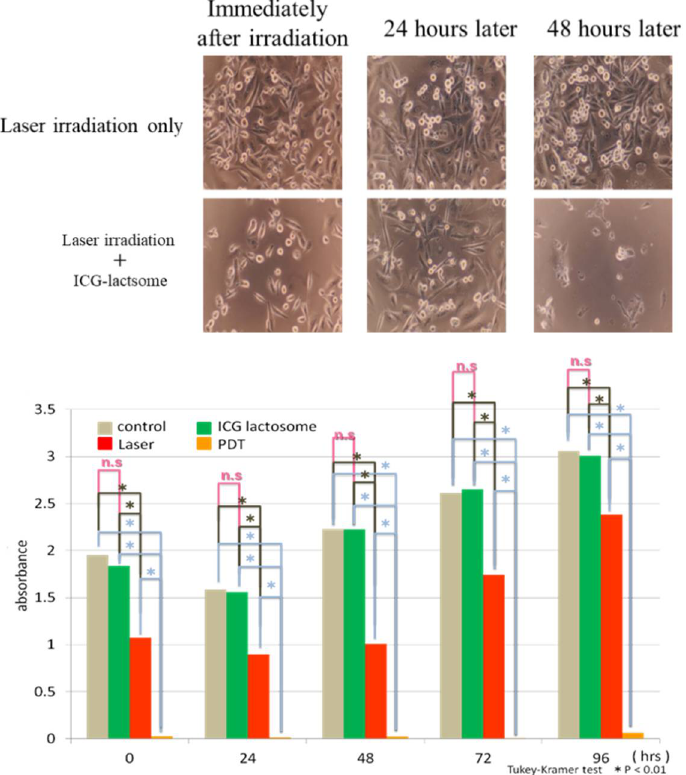
Figure 4. Tumor cell proliferation of the human breast cancer cell line MDA-MB-231 is suppressed by ICG-lactosomes. ICG-lactosomes combined with laser irradiation abolished cells (lower panels). Mean absorbance values indicate cell viability in the WST-1 assay. The laser-irradiated group ( red ) showed significantly lower cell viability than the control and ICG-lactosome alone ( green ) groups. The fluence rate and irradiation period were set to 298 mW/cm 2 and 60 s, respectively, corresponding to a fluence of 17.9 J/cm 2 . Furthermore, the photodynamic therapy (PDT) group ( yellow ) showed drastically lower cell viability compared to the laser group [20]. n.s, not significant; * p < 0.01. (Reproduced from Ozeki and Hara [17]).